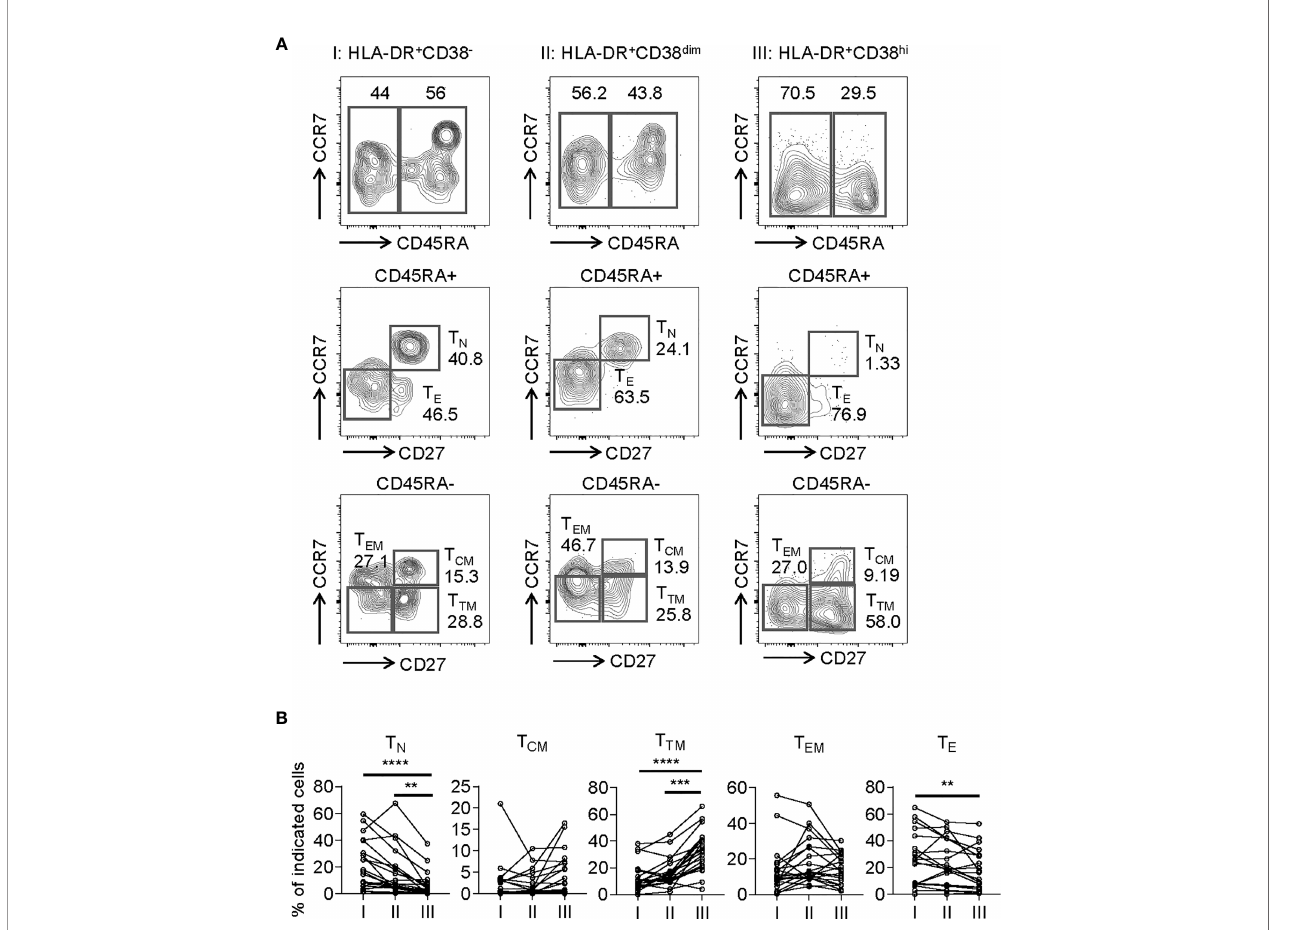
FIGURE 2 | HLA-DR + CD38 hi CD8 + T cells consisted of enhanced percentage of T TM and decreased T N and T E . Flow cytometry analysis of T N , T CM , T TM , T EM , and T E frequency was performed on PBMCs collected from patients with infection of COVID-19 (n = 20). (A) Gating strategy for T N , T CM , T TM , T EM , and T E in three CD8 + T populations. (B) The percentage of T N , T CM , T TM , T EM , and T E on each CD8 + T population (I, II, III). P Values were obtained by paired two-tailed Student ’ s t tests and Wilcoxon matched-pairs signed-rank test and repeated measures by one-way ANOVA or Friedman test followed by Holm-Sidak ’ s multiple comparisons or Dunn ’ s multiple comparisons test. **P < .01, ***P < .001, ****P <